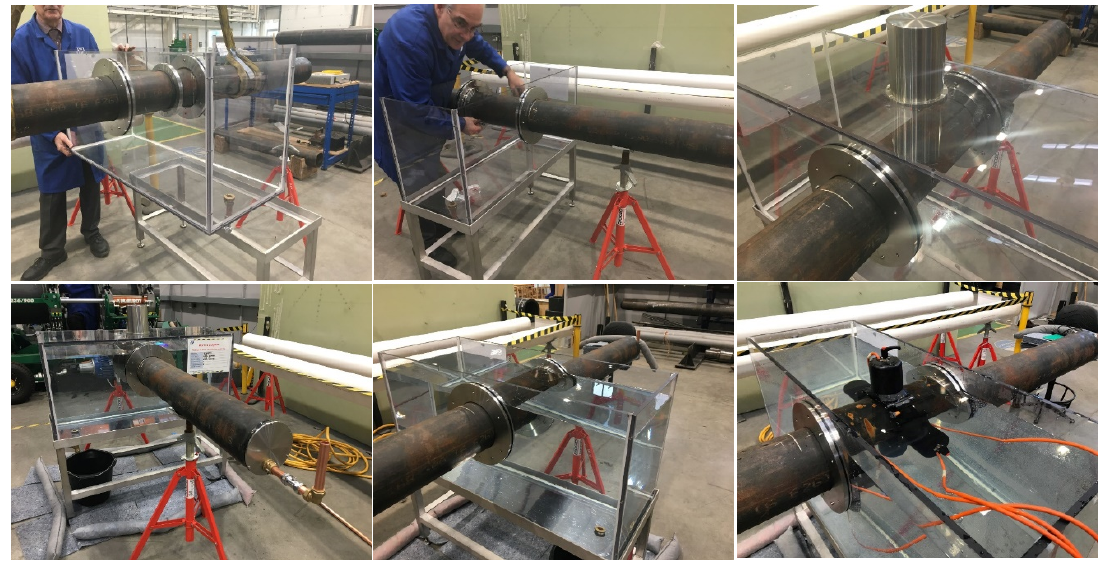
Figure 22. Assembly of the integrated system demonstration tank.